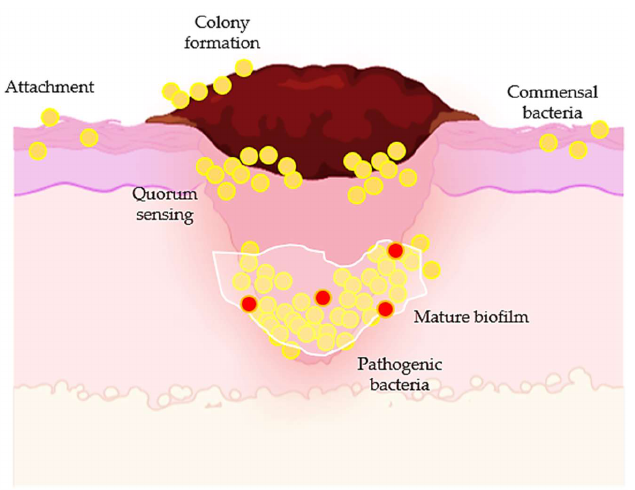
Figure 4. The colonization of commensal bacteria as the injury occurs. Biofilm production may cause delayed wound healing and treatment failures, as well as susceptibility to new infections, as the production of biofilms prevents drug penetration. Table 3. The application of flavonoids as anti-bacterial agents on wound healing.